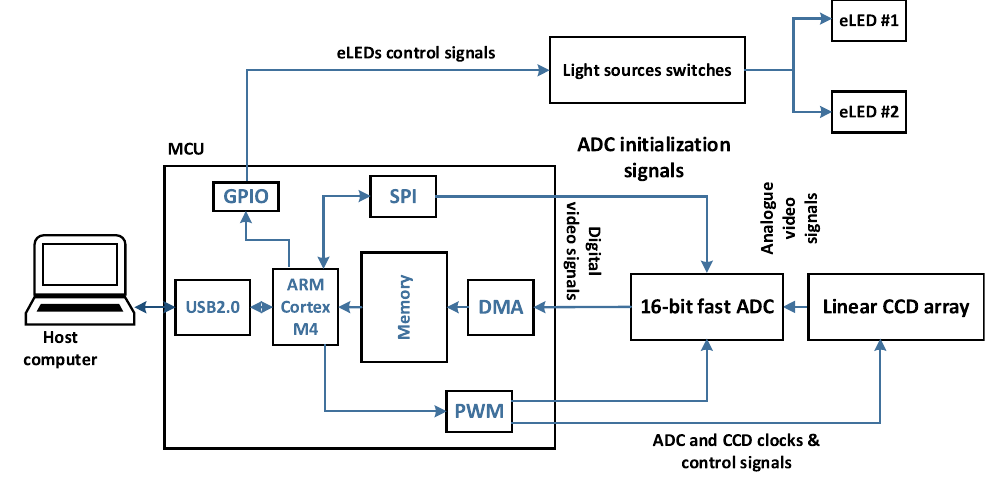
Fig. 2. Schematic of the cross-sectional di®use optical imaging instrument.